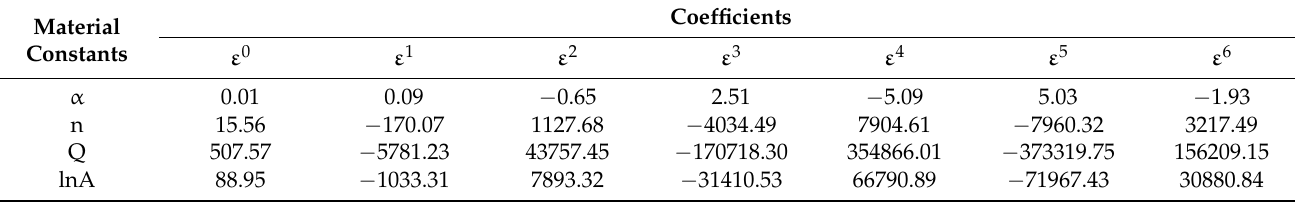
Table 1. The coefficient of material constants and true strain during fitting